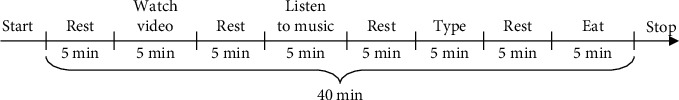
Scenario process diagram.